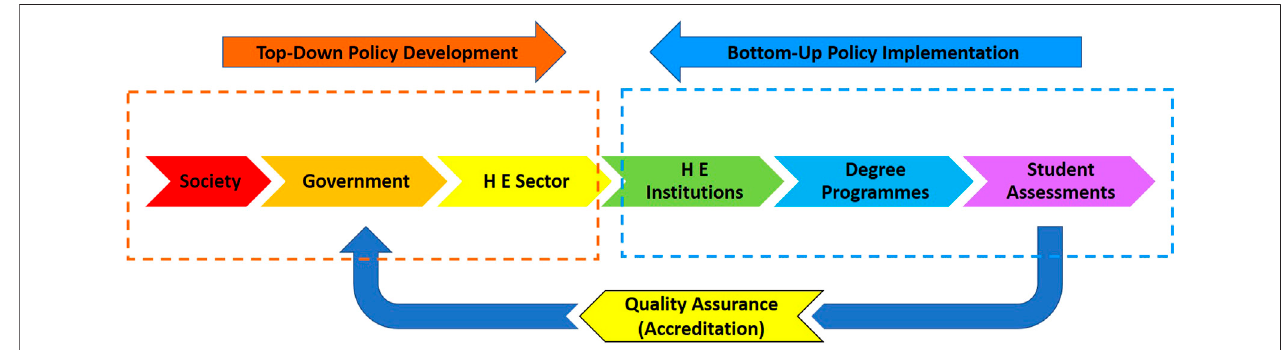
FIGURE 1 | Educational policy